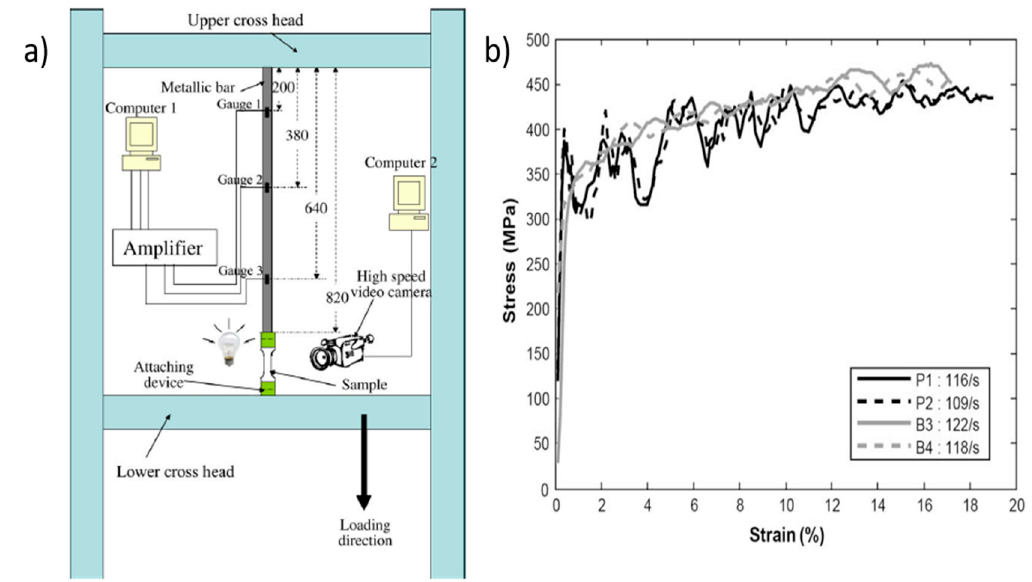
Figure 2. ( a ) Modified hybrid machine and ( b ) stress–strain relation for aluminum obtained by the piezoelectric load sensor method (P1 and P2) and by the Hopkinson bar technique (B3 and B4), (the figure is reproduced from [55], with permission from Elsevier, 2009).